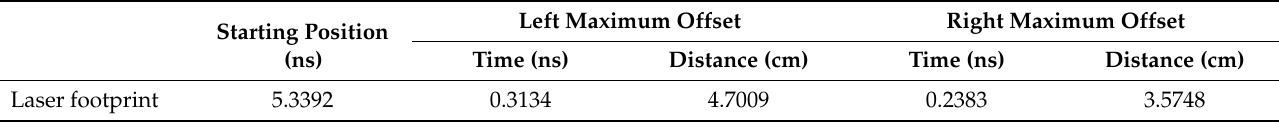
Table 2. Comparison of initial channel selection results considering transmitter pulses.